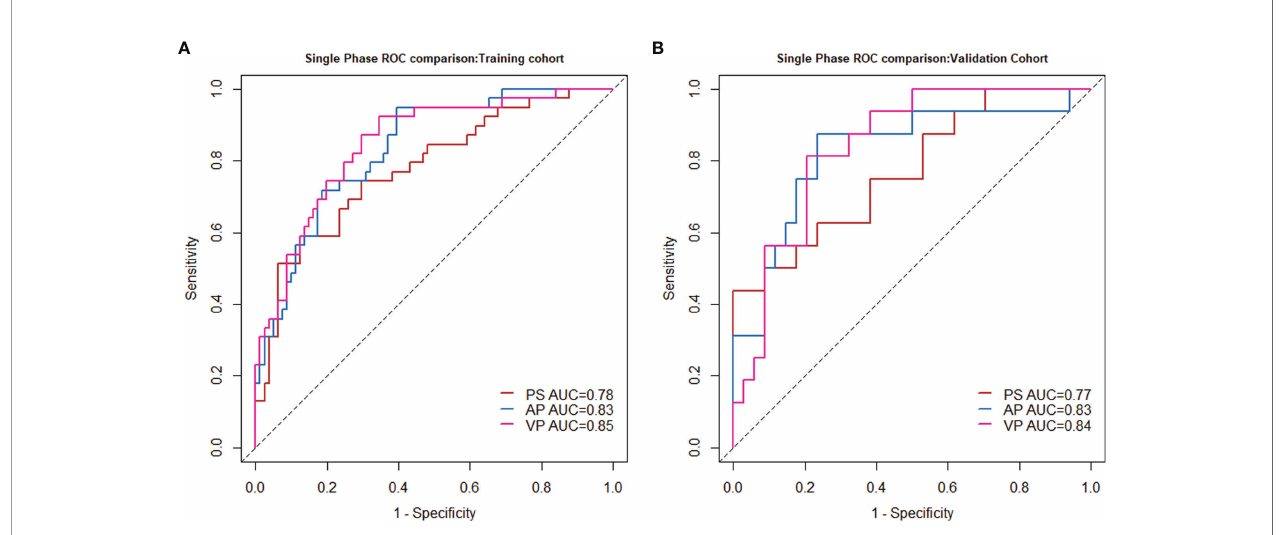
FIGURE 2 | Single-phase radiomics model performance in the training cohort (A) and validation cohort (B)